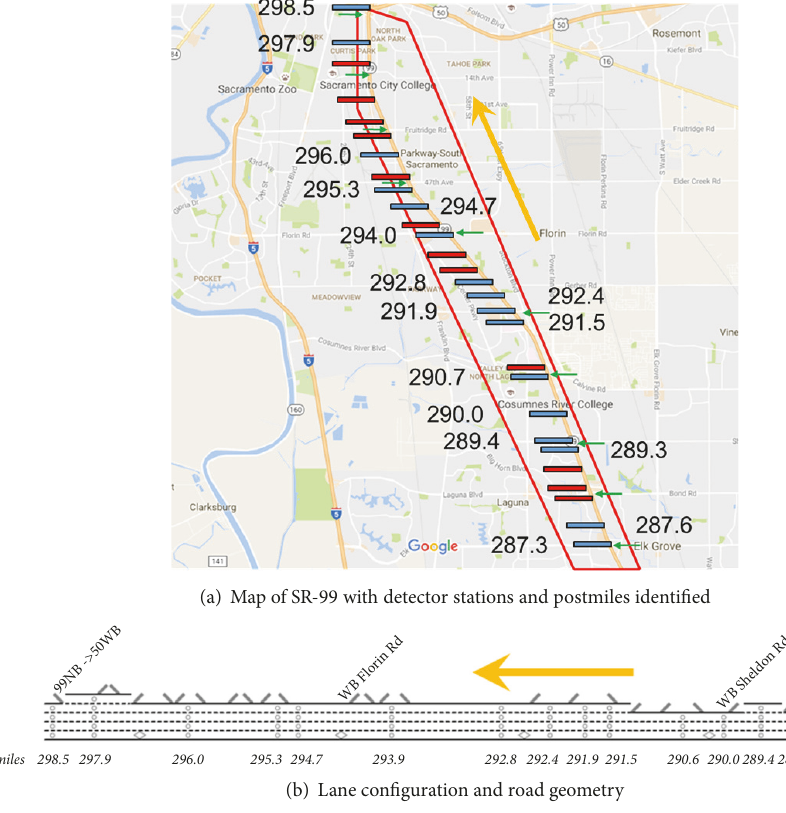
Figure 3: Study site: SR-99 freeway south of downtown Sacramento,